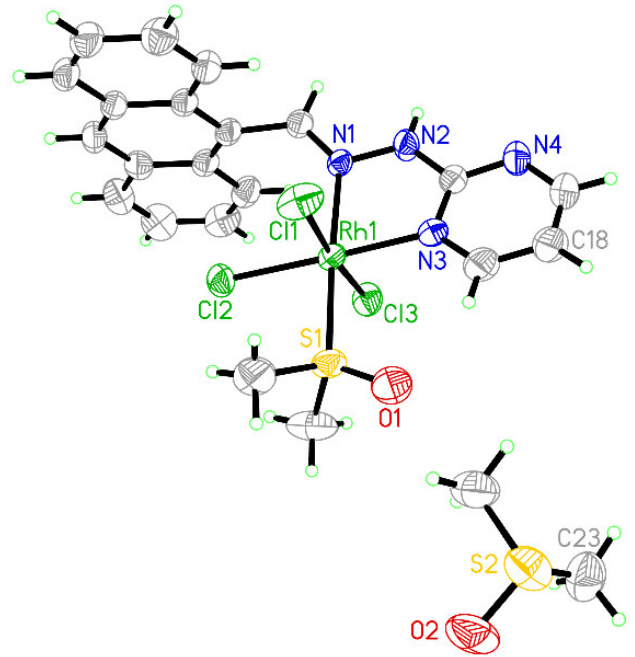
Figure 1. An ORTEP view of the title complex, 9-PMAH-Rh, showing displacement ellipsoids at the 50% probability level (co-crystalized solvent DMSO omitted for clarity).